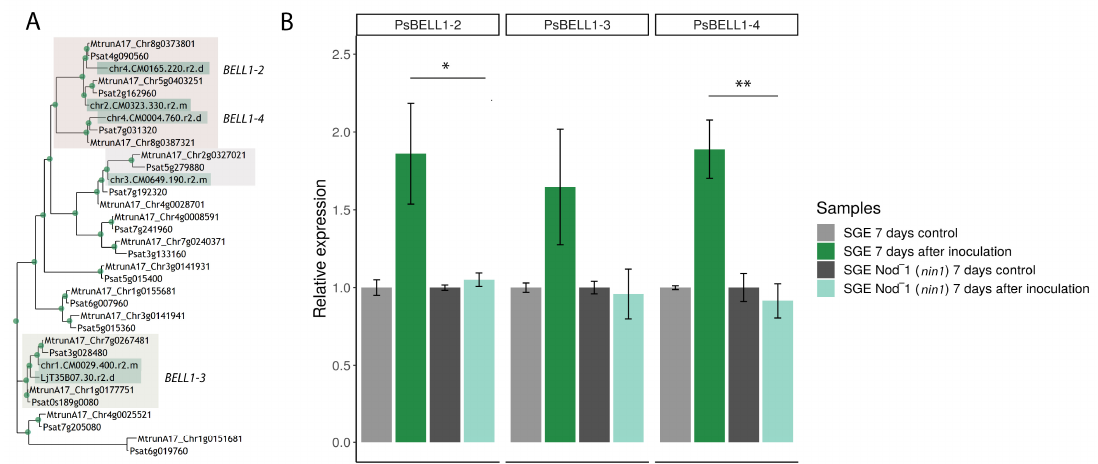
Figure 4. Phylogenetic tree constructed by the maximum-likelihood method based on amino acid sequences of Medicago truncatula and Pisum sativum BELL genes and Lotus japonicus homologous BELL genes detected in ChIP-Seq analysis. Green dots indicate support more than 70 based on 1000 bootstrap replicates ( A ). Expression pattern of PsBELL1-2 (Psat4g090560) , PsBELL1-3 (Psat0s189g0080)